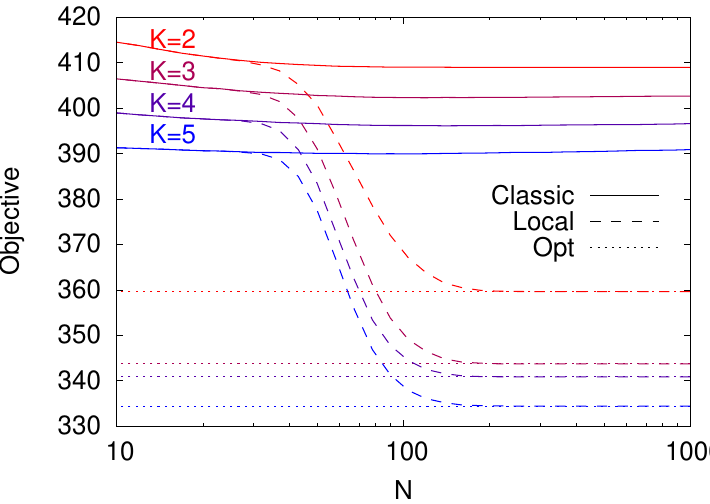
Figure 4 Experiment 3: Average objective values of solutions based on locally and classic budgeted